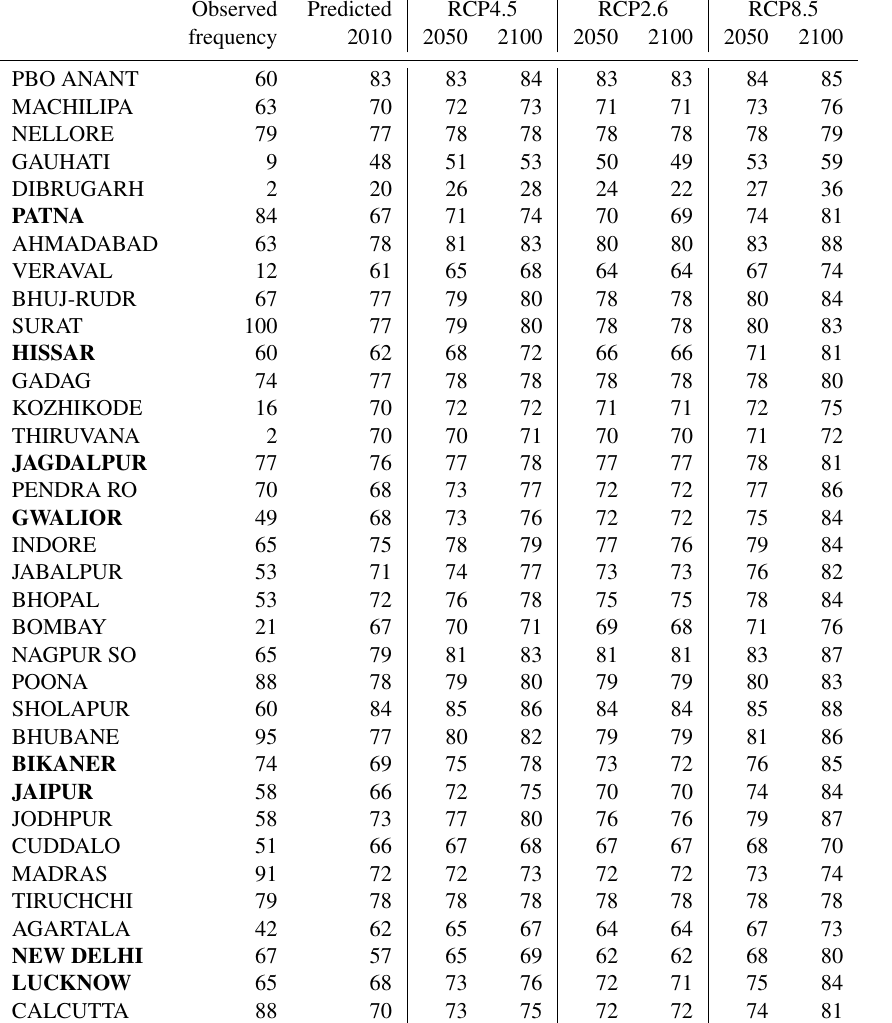
Table 1. Estimated probability (expressed in %) for an episode with temperatures exceeding 35 ◦ C over more than 5 consecutive days in February–April. The observed frequency was based on the individual observational record and length of time series, and it is not exactly equivalent to the estimated probability for 2010. The location names in bold font mark stations within the IGP